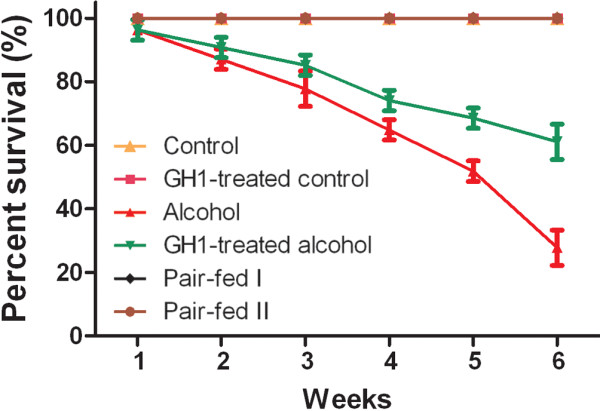
Survival rates. The survival rate was 100% at baseline and decreased to 24.07 ± 3.21% in the alcohol-fed group and 66.96 ± 5.56% in the GH1-treated alcohol-fed group after 6 weeks of treatment. The survival rate was maintained at 100% in the other groups. n = 18 mice per group for the alcohol and GH1-treated alcohol groups; n = 6 mice per group for the other groups.